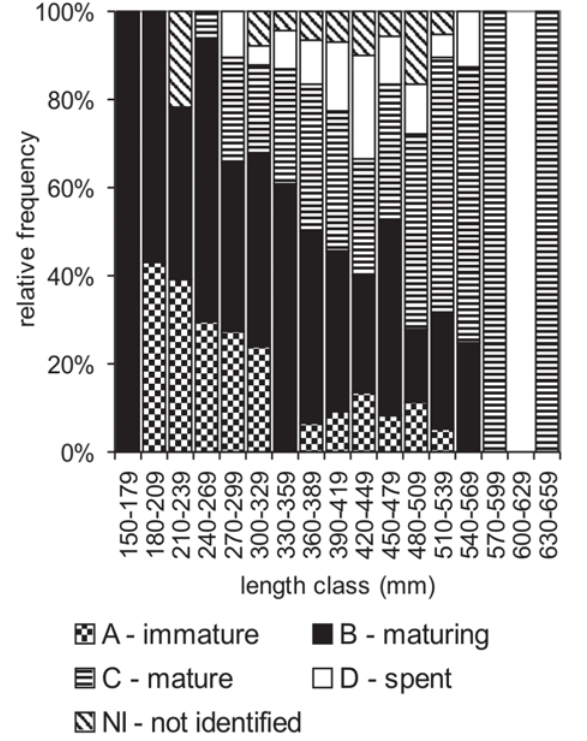
Fig. 2. Merluccius hubbsi : relative frequency of females by stage of gonadal maturation identified macroscopically by class of total lenght (n =